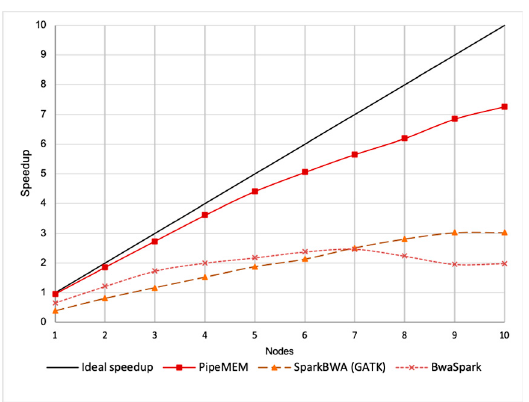
Figure 8. Comparison of throughput between PipeMEM, BWASpark, and SparkBWA. The ideal line is drawn under the assumption that BWA-MEM can be scaled with the efficiency of one. It’s easy to see that the performance of PipeMEM is the best among three tools, and it is the closest one to the ideal line. The throughput of BWASpark reaches its highest point at seven nodes and start decreasing. This is because the speedup brought by using more nodes is less than the overhead caused by additional nodes. The trend of SparkBWA and PipeMEM are similar because they used a similar strategy.